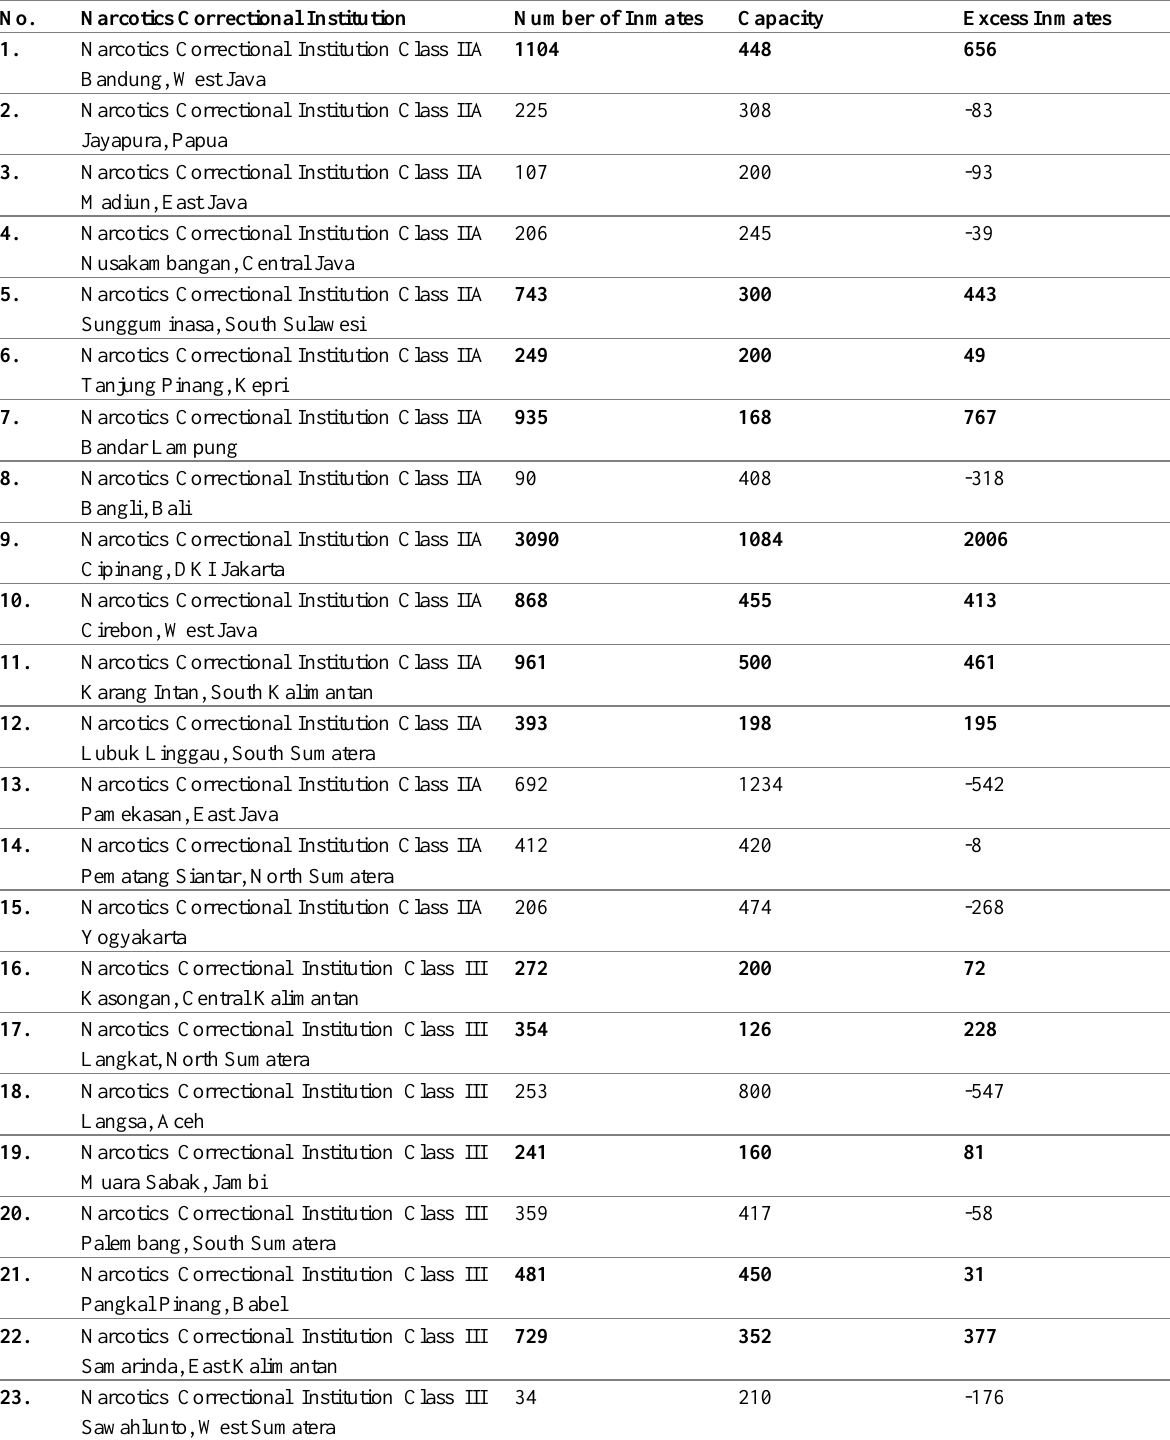
Table 1: Condition of Correctional Institution Capacity in